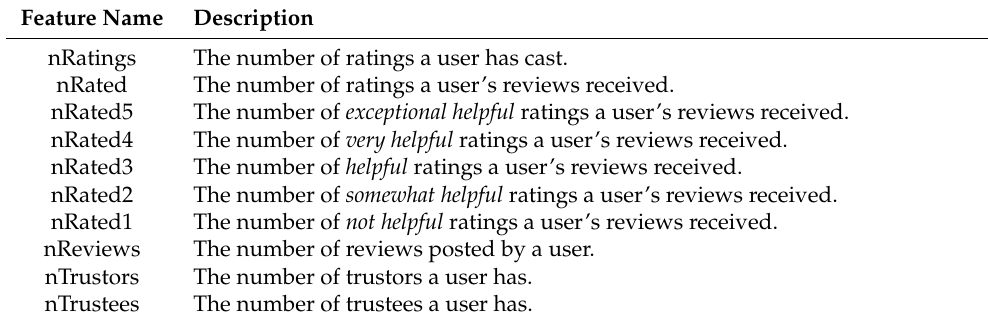
Table 3. Statistical features for user profiles used in the proposed